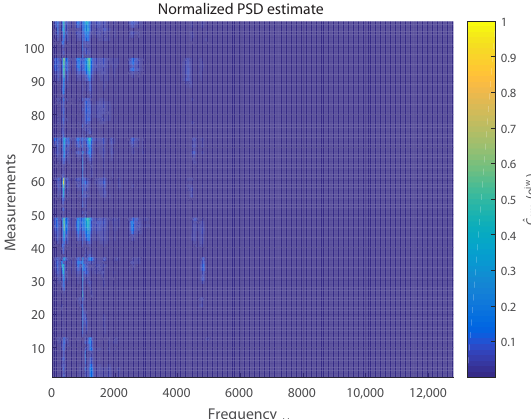
Figure 7. Normalized PSD estimates.